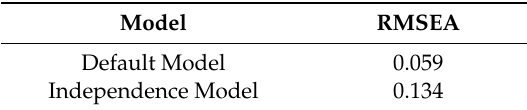
Table 6. Root Mean Square Error of Approximation